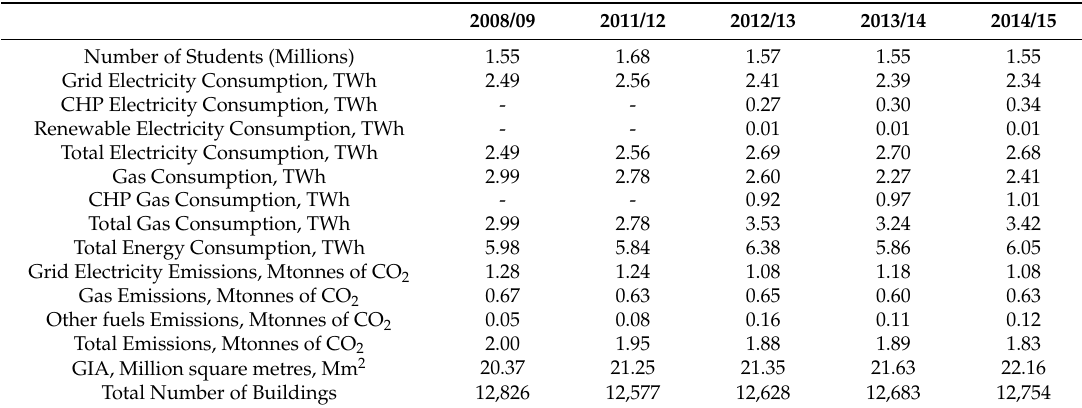
Table 1. Five years statistics for England’s Higher Education